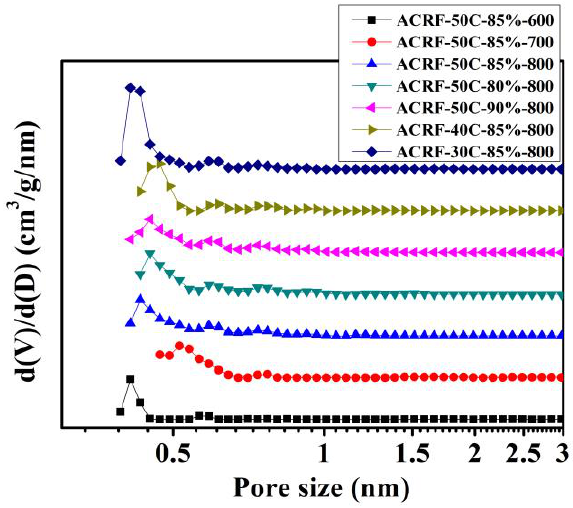
Figure 5. Pore size distributions of ACRFs.